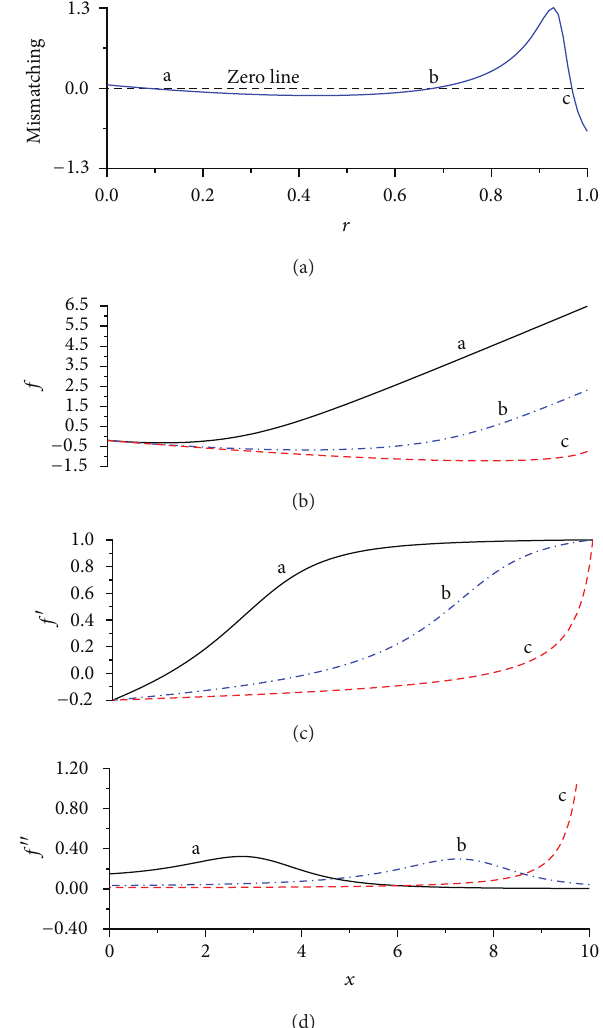
Figure 11: The boundary layer problem of a power-law fluid with 𝑁 = 0.3 solved by the SL (3, R ) method, (a) showing the error of mismatching and iterations number and showing three different numerical solutions of (b) 𝑓 , (c) 𝑓 󸀠 , and (d) 𝑓 󸀠󸀠